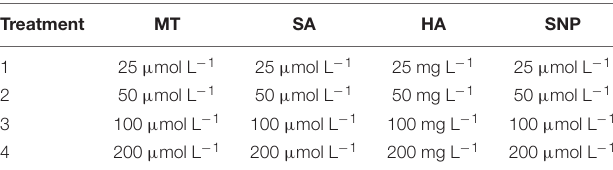
TABLE 1 | Concentrations of four exogenous growth regulators (MT, melatonin; SA, salicylic acid; HA, humic acid; SNP, sodium nitroprusside) used in the